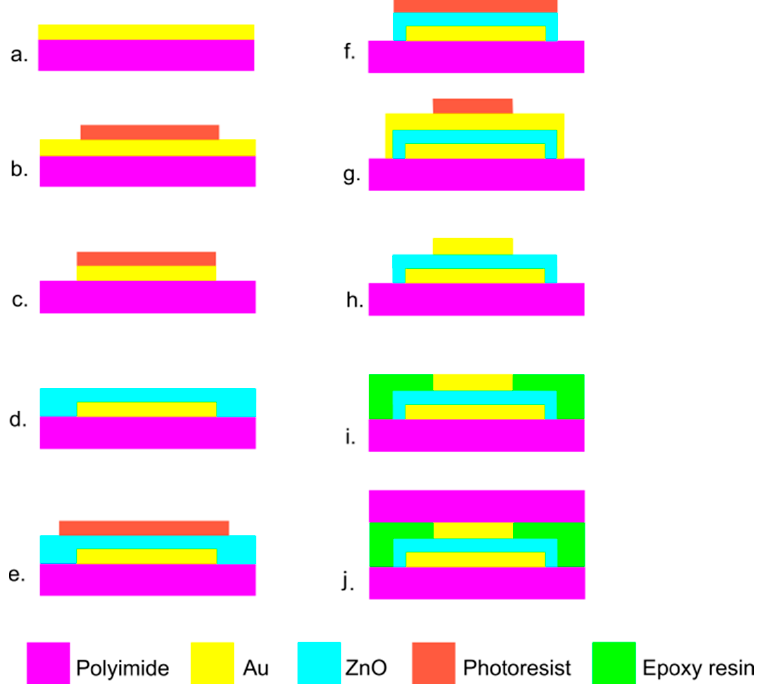
Figure 6. Flow-chart describing the process steps of the PPT in CPE configuration fabrication process: ( a – h ) deposition and patterning of the electrodes and ZnO thin film; ( i , j ) assembly of the final PPT structure.